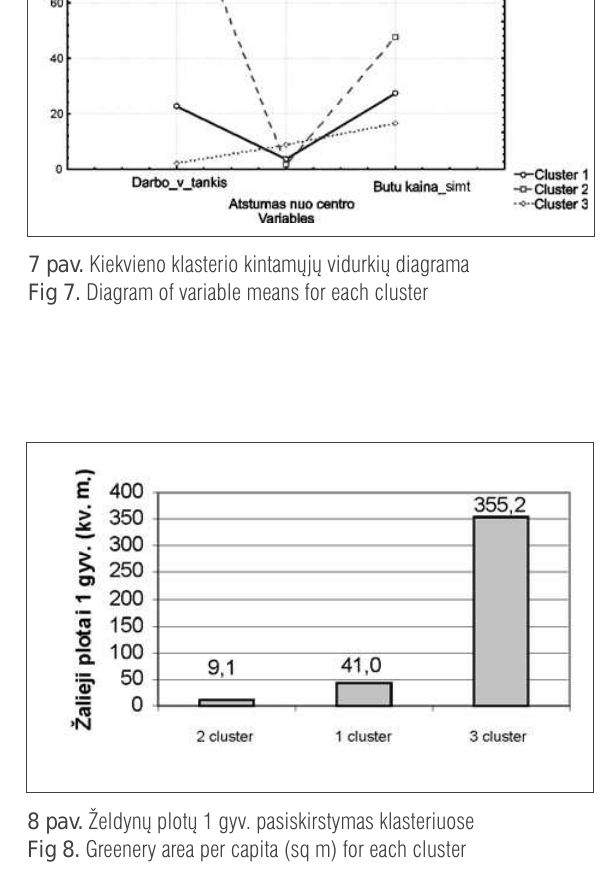
Fig 8. Greenery area per capita (sq m) for each cluster